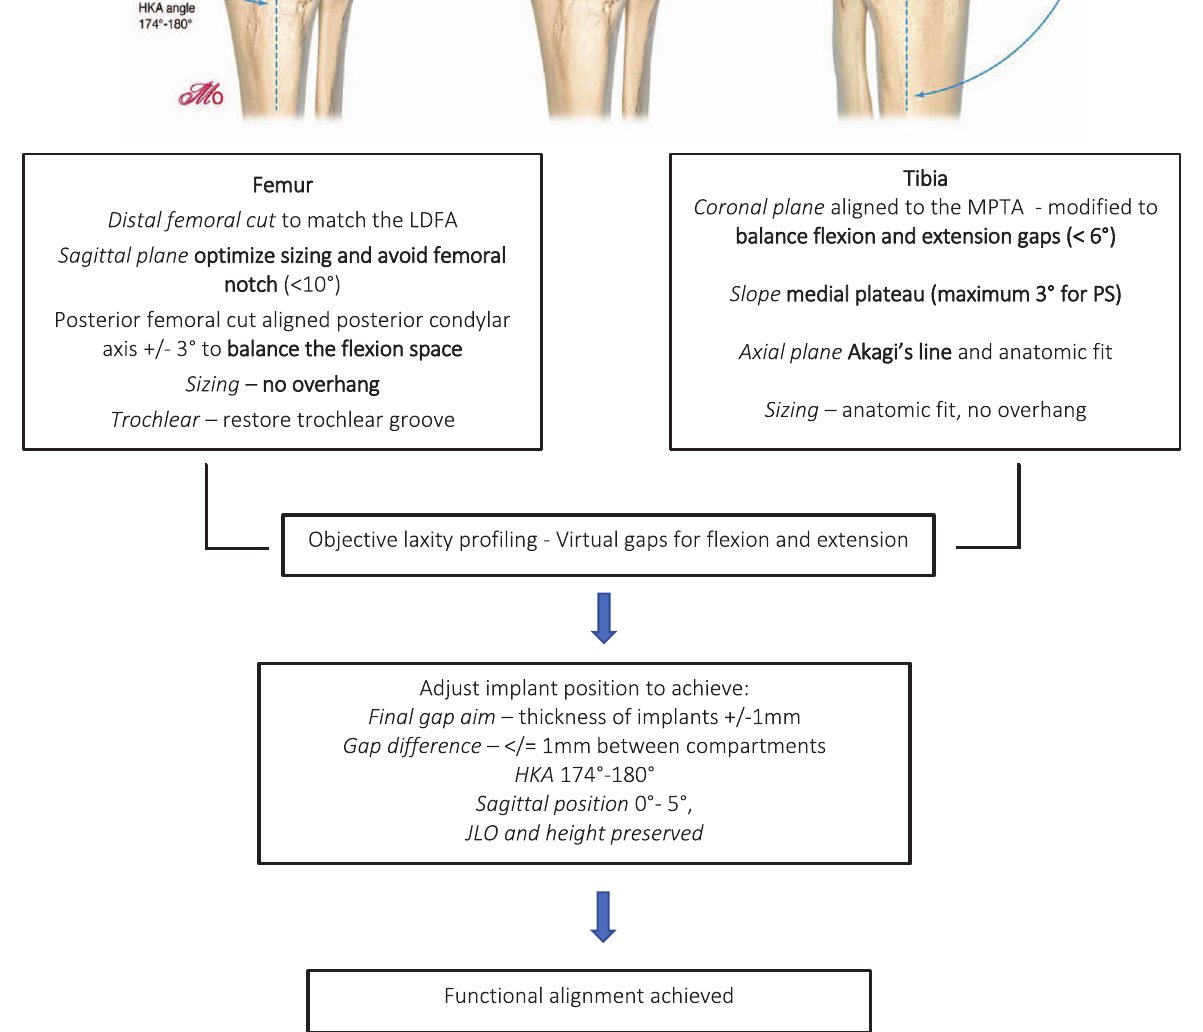
Figure 1. Functional alignment surgical work fl